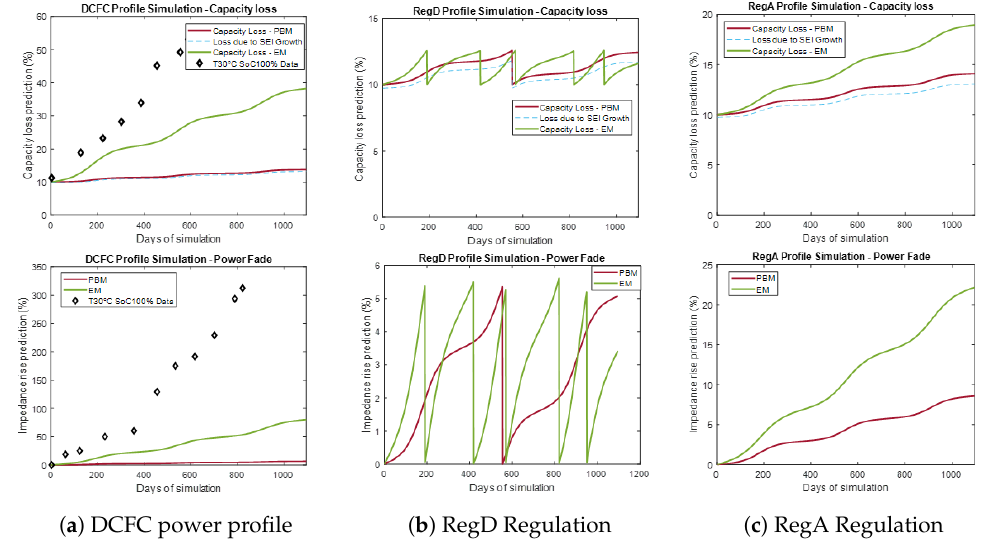
Figure 13. Comparison of capacity and power fade prediction of the EM and PSM for three different power